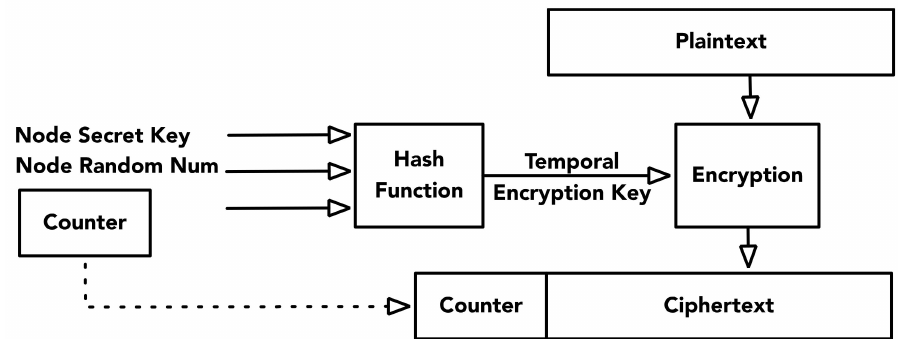
Figure 4. Temporal encryption key generation and message encryption.